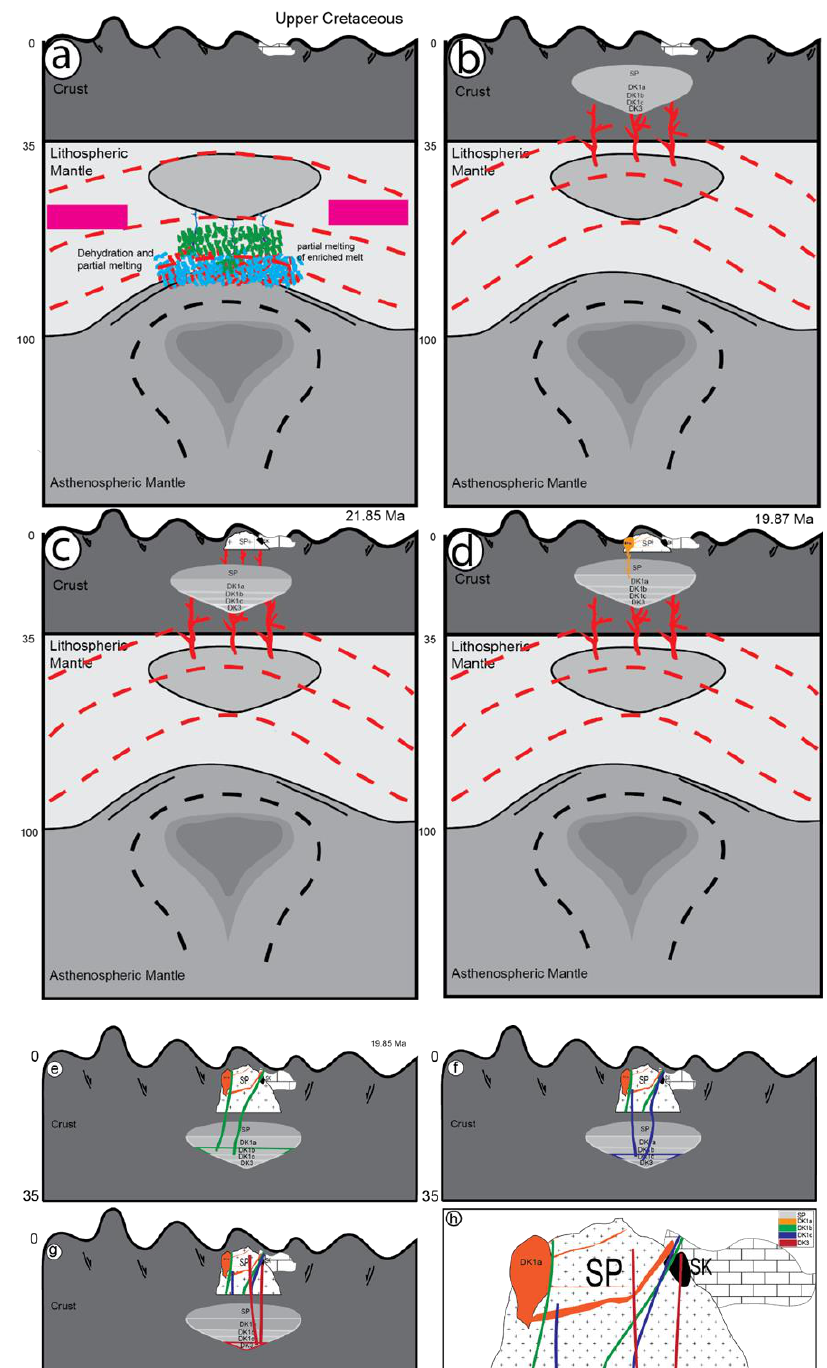
Figure 17. Model showing the Three-stage emplacement of the post-mineralization dykes. ( a , b ) Neotethys closure in the upper Cretaceous and the onset of metasomatism in the asthenosphere and the lithosphere; ( c ) enplacement of the Sungun Porphyry 21 million years ago; ( d ) injection of the first (DK1a) and oldest post-mineralization dykes; ( e-h )Simplified cartoons showing the geodynamic and petrogenetic evolution of the post-mineralization dykes within the Sungun porphyry deposit. ( e ) quartz diorite dykes injection in the Sungun porphyry; ( f ) further injection of quartz diorite dykes; ( g ) the emplacement of the inclusion-rich quartz diorite; and ( h ) schematic diagram shows the post-emplacement geometry (cross-section) of the Sungun porphyry and post mineralization dyke in Varzaghan, NW